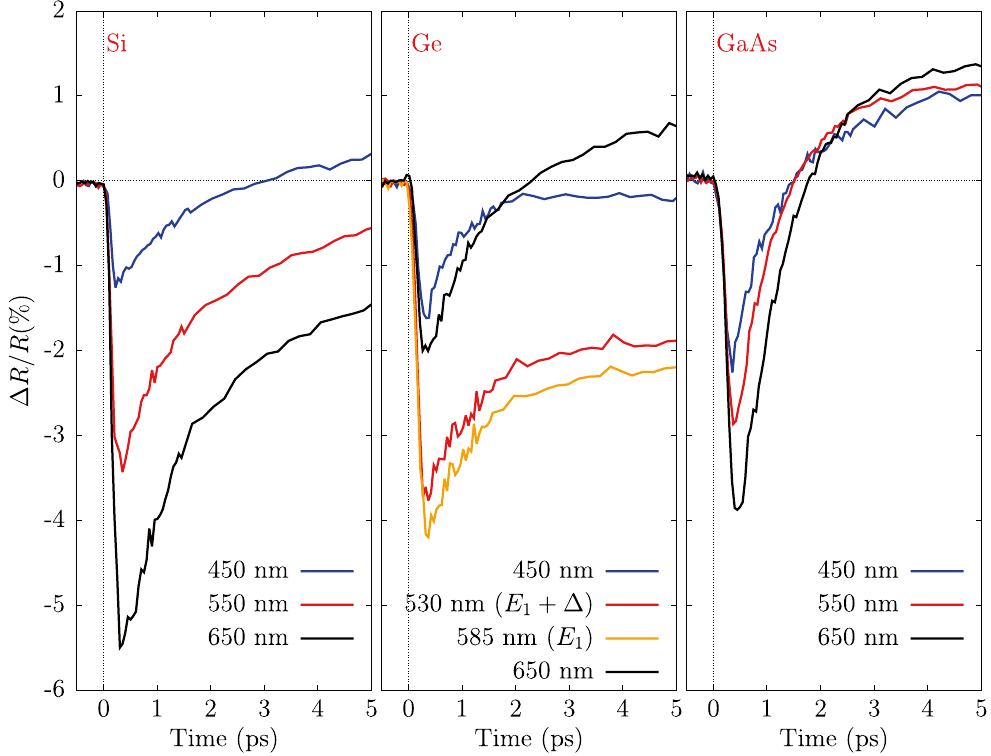
Figure 3. Time evolution of � R / R for Si (left panel), Ge (center panel) and GaAs (right-hand panel). Probe wavelength are 450 nm, 550 nm and 650 nm for Si and GaAs, while for Ge E 1 and E 1 + (cid:31) transitions wavelength instead of 550 nm. Pump fluences were 16 mJ/ cm 2 , 16 mJ/ cm 2 and 6.4 mJ/ cm 2 for Si, Ge and GaAs